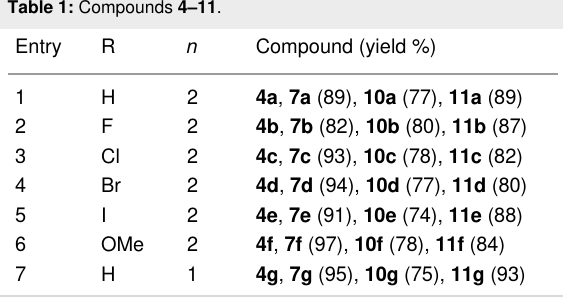
Table 1: Compounds 4–11